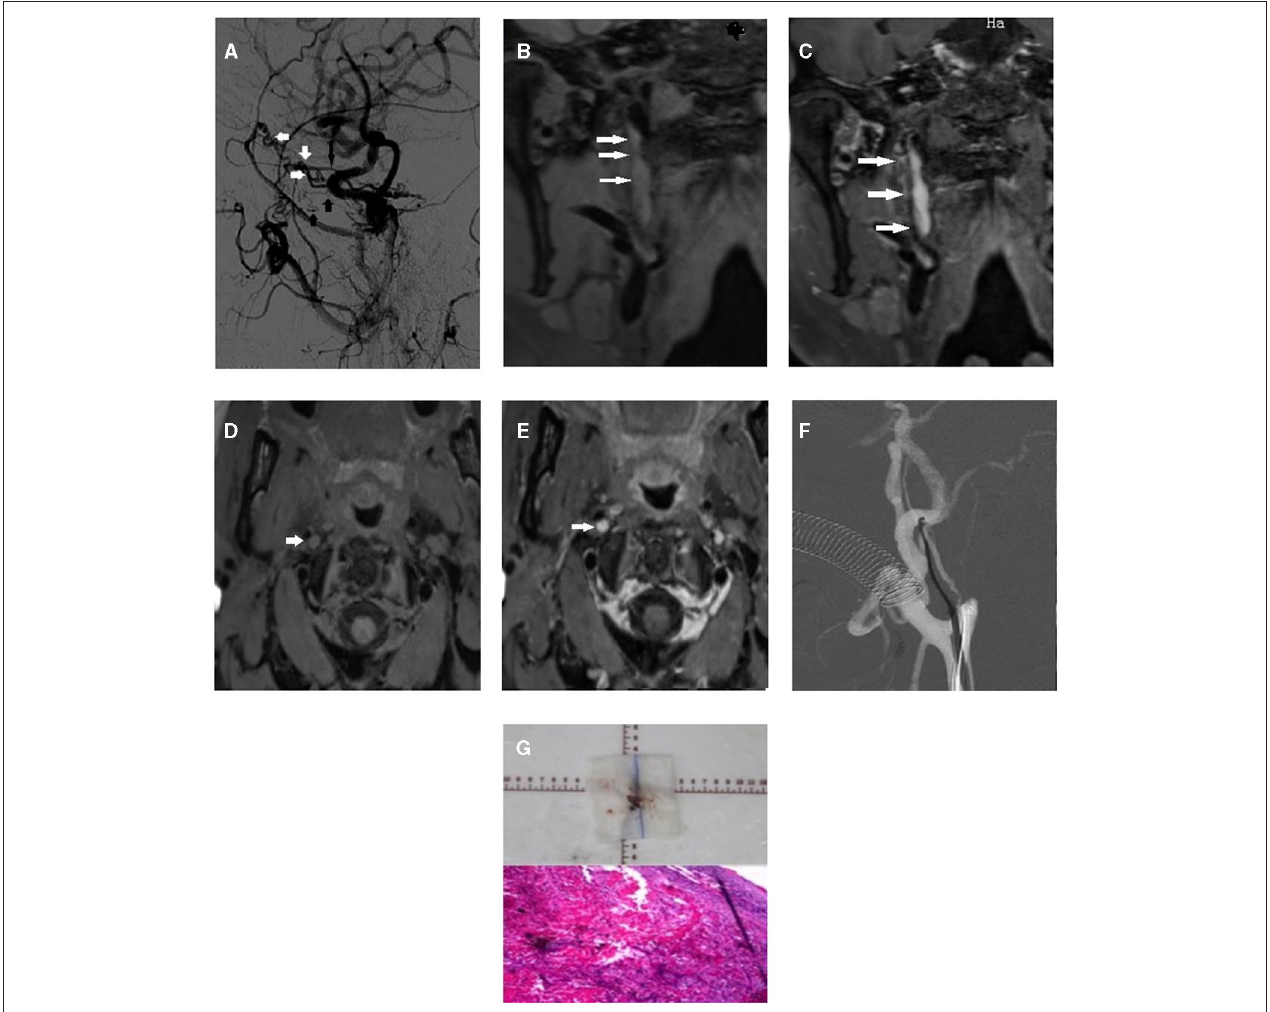
FIGURE 2 | First illustrative case of right internal carotid artery chronic occlusion with border zone infarction. (A) Lateral image of occluded internal carotid artery on DSA exhibited multiple collaterals from extracranial carotid artery (white arrow: recurrent meningeal artery, short black arrow: artery of the foramen rotundum, long black arrow: ophthalmic artery). (B) Long atresia lumen was detected on coronal scan of unenhanced 3D SPACE MRI (white arrow). (C) On enhanced coronal scan, intraluminal slight enhancement was detected (white arrow). (D) On unenhanced cross-section, occluded internal carotid lumen was exhibited (white arrow). (E) Intraluminal enhancement after contrast injection (white arrow). (F) After all attempts with multiple guidewires, passing through the occluded site was still failed. (G) Biopsy from carotid endarterectomy revealed old thrombosis at the occlusion